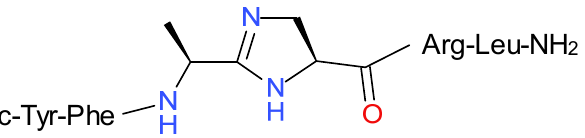
Figure 2. Structure of PPK-Jo, a selective agonist in one of four PK-related bioassays [3,5]. Another member of the PK neuropeptide family, the diapause hormone (DH), has been shown to terminate the protective state of diapause in pupae of heliothine moths [15]. The imidazoline motif was incorporated into the C-terminal heptapeptide active core region (LWFGPRLa) of DH [4,5], transforming a DH agonist into an antagonist capable of blocking the diapause termination activity of the native hormone in the corn earworm moth H. zea . The analog provides a lead for the development of DH analogs that can con-